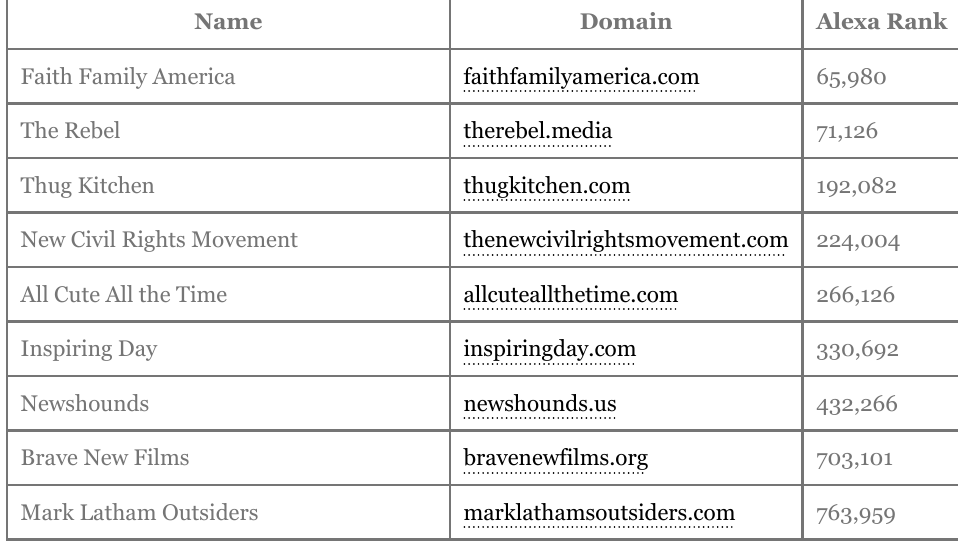
Table 2: Top media outlets using NationBuilder, according to Alexa ranking (the lower the number, the more popular the